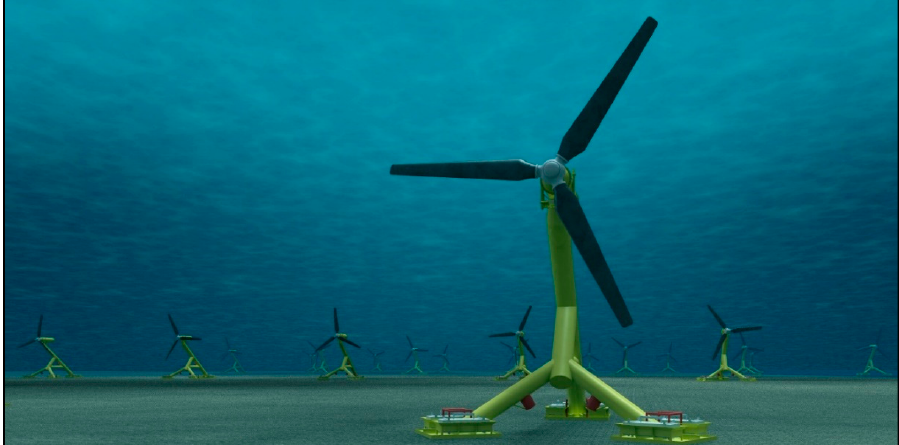
Figure 2. Tidal stream turbine (Andritz Hydro